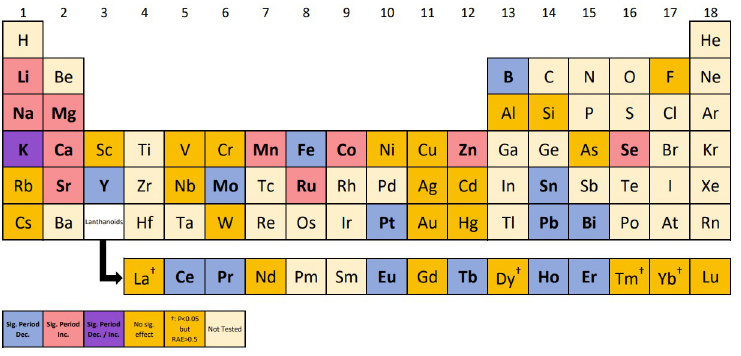
Fig 2. The effect on period using FFT-NLLS methods. An element (see Tables 1–3) is defined as having a significant effect (and denoted in bold ) if at least one corresponding chemical treatment gave a significant result ( p < 0.05 and RAE < 0.5). Colours denote the type of induced change (see